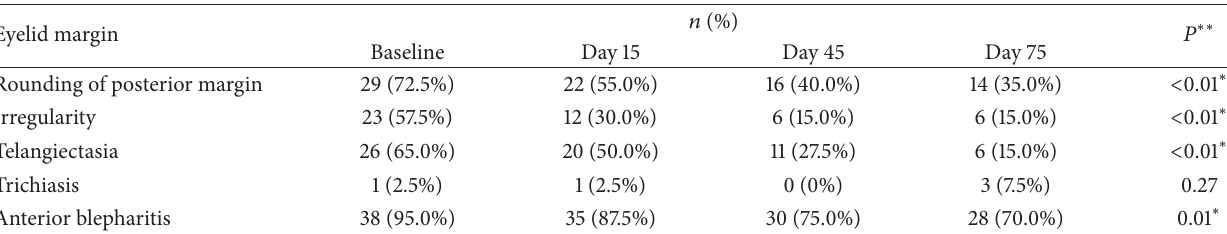
Table 2: Evaluation of eyelid margin signs during IPL